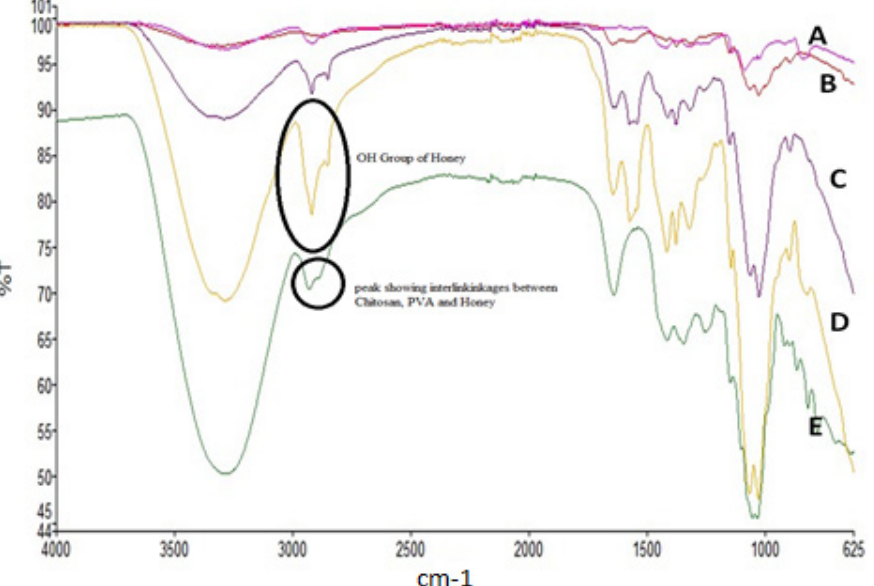
Figure 3. FTIR spectra of ( A ) PVA, ( B ) chitosan, ( C ) film with honey (formulation containing PVA/chitosan/honey), ( D ) honey, ( E ) film without honey (formulation containing PVA/chitosan).